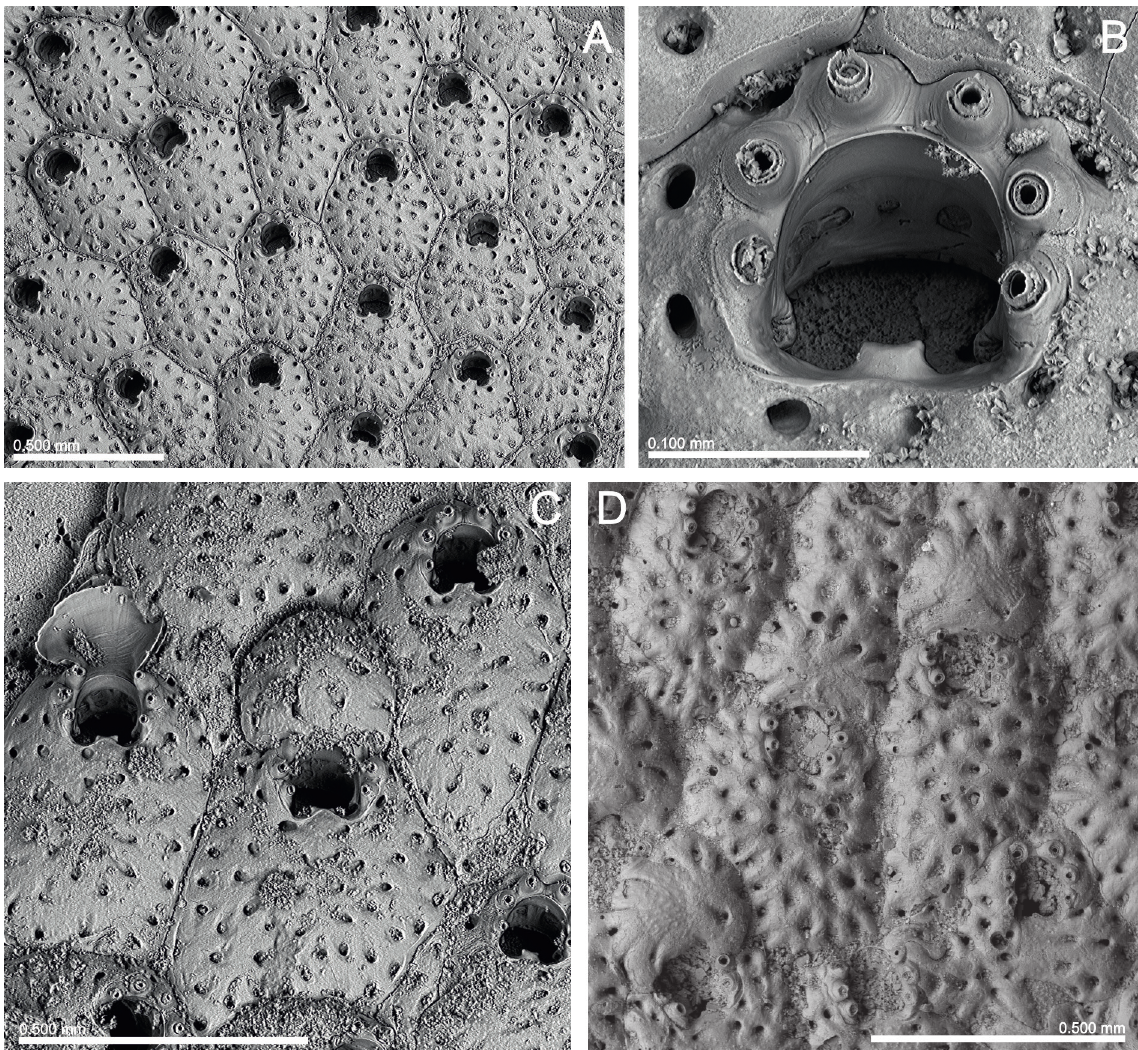
Fig. 6. Escharella guernei (Jullien & Calvet, 1903) comb. nov. A . Autozooids (MOM INV-22518, lectotype). B . Same , primary orifice. C . Same, ovicellate zooids. D . Ovicellate and non-ovicellate zooids; note the ovicells, recumbent or immersed (MNHN